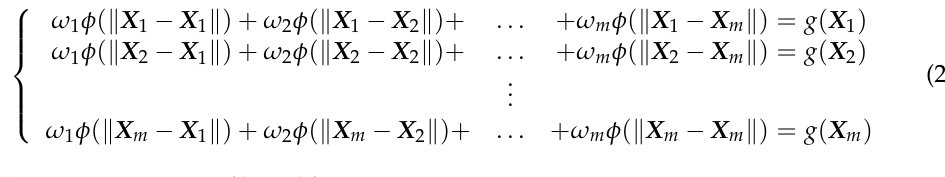
Table 1. Common types of kernel functions. Type Name Expression